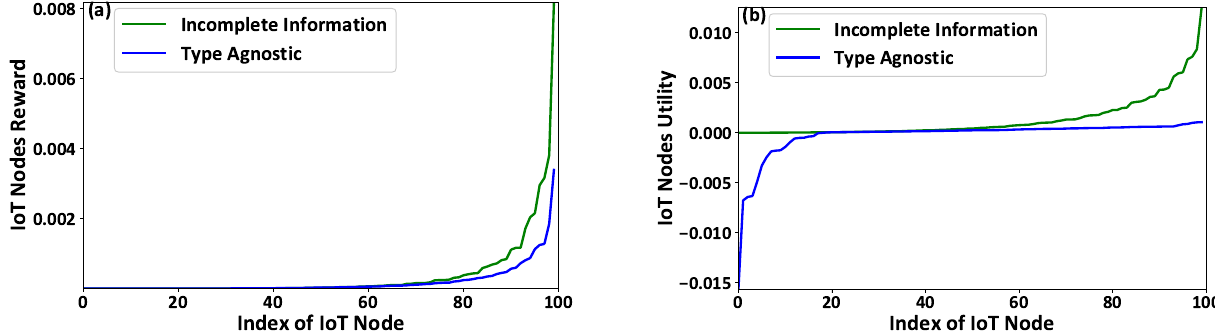
Figure 4. ( a ) IoT nodes reward and ( b ) achieved utility under the contract-theoretic versus the type agnostic framework of energy